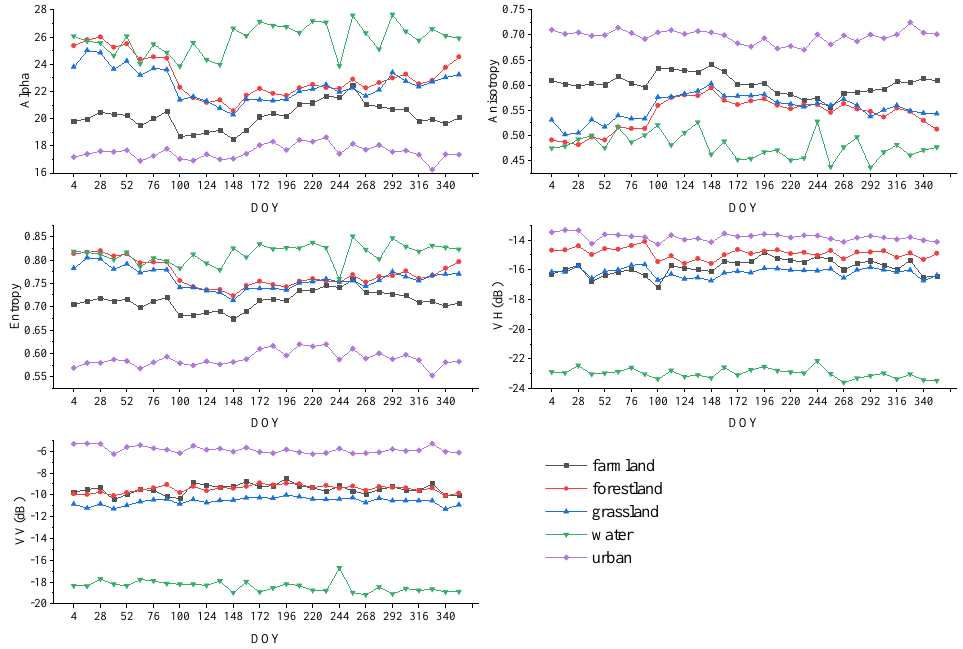
Figure 7. Temporal curves of SAR parameters for VV, VH, alpha, anisotropy, and entropy of five